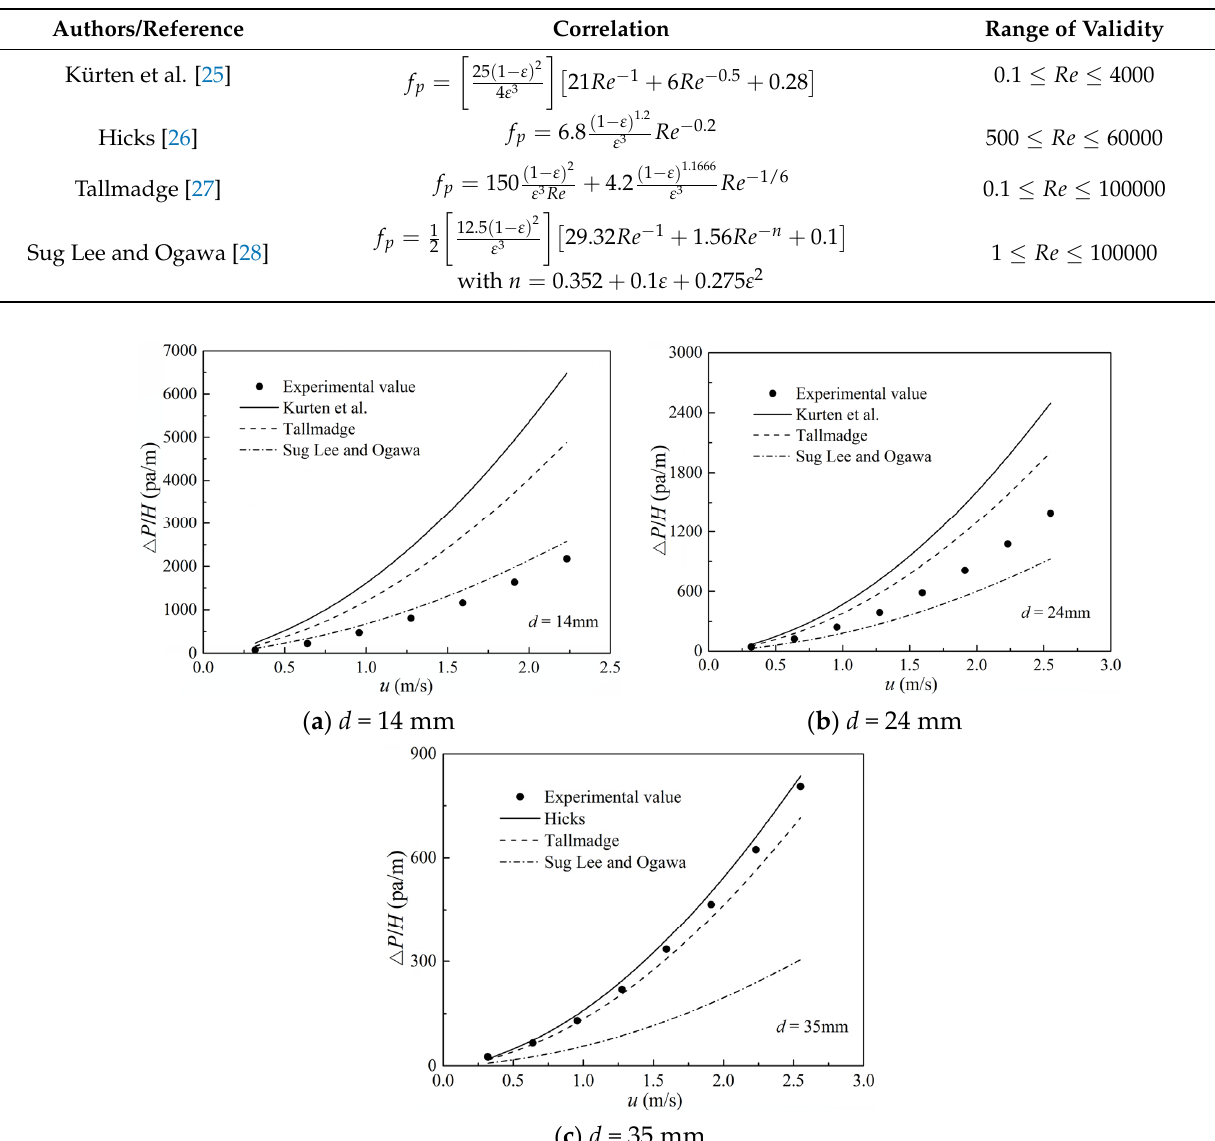
Table 2. Correlations for fluid FPD in packed bed with particles.